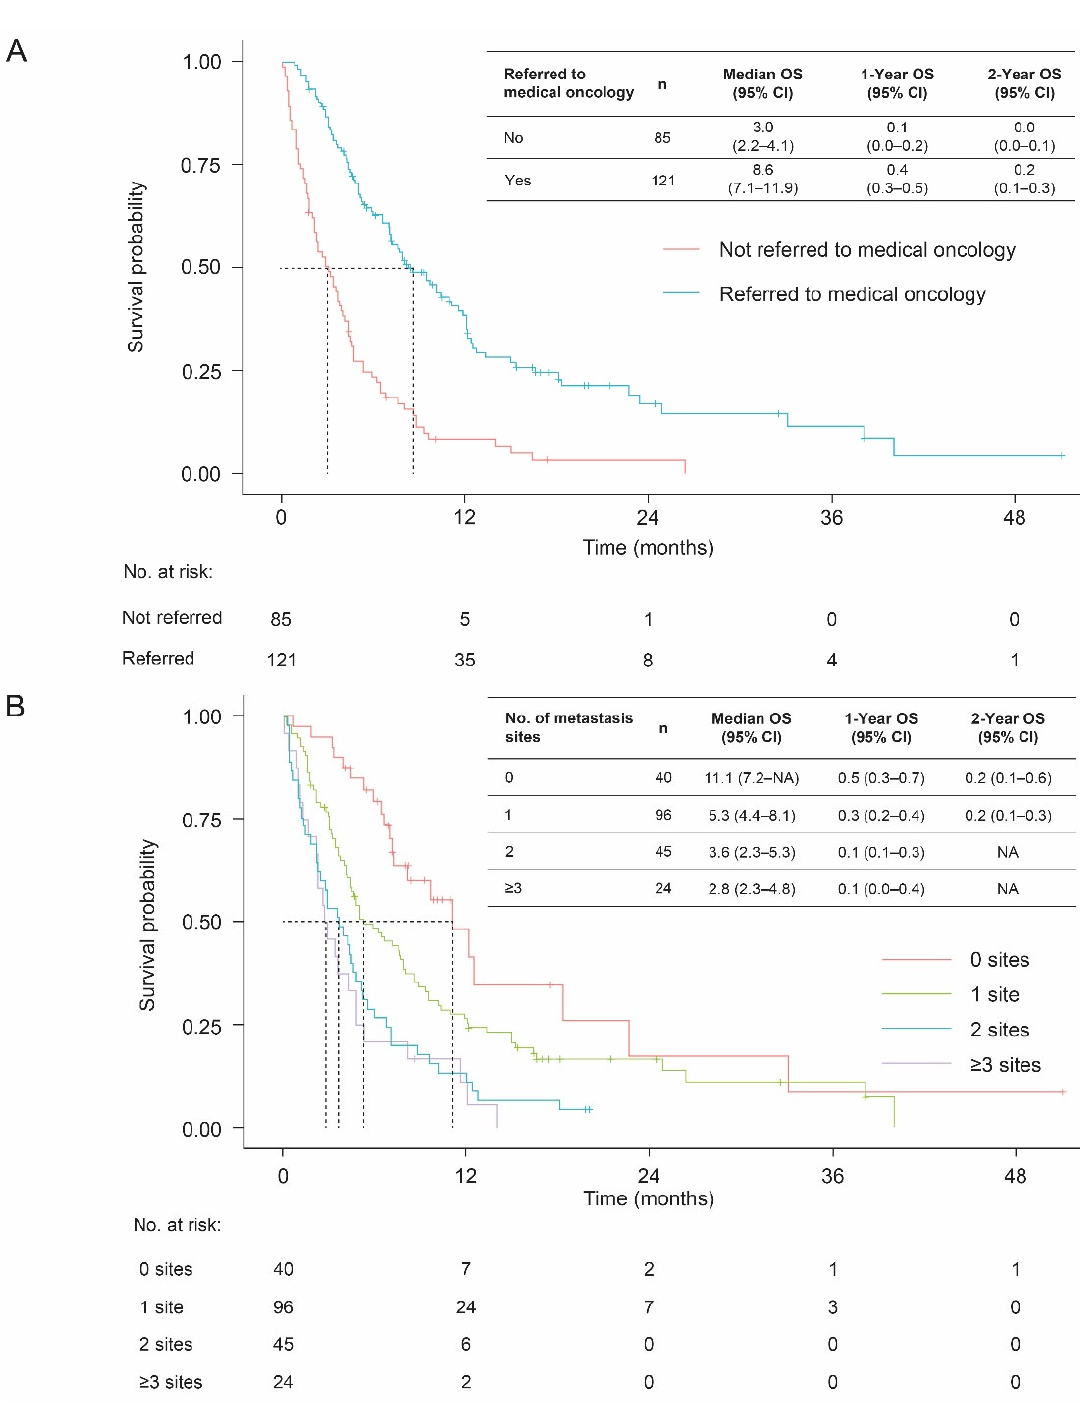
Figure 2. OS from start of second ‐ line therapy among patients with de novo la/mUC following ini ‐ tiation of second ‐ line systemic therapy, ( A ) overall, and ( B ) by therapy received. Abbreviations: 2L, second line; CI, confidence interval; la/mUC, locally advanced or metastatic urothelial carcinoma; NA, not available; OS, overall survival.